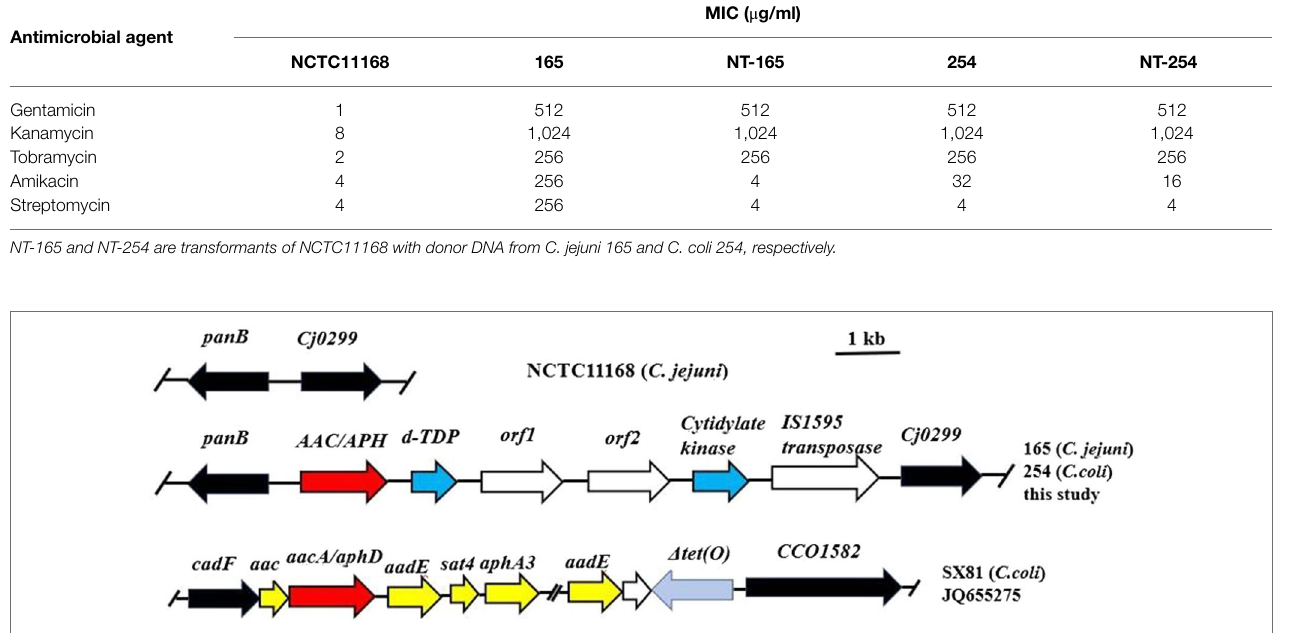
Antimicrobial agent